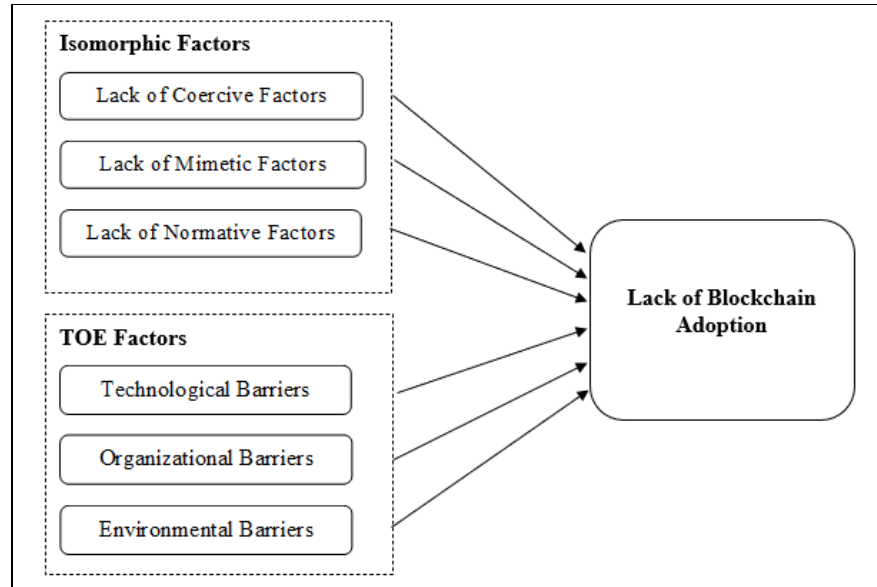
Figure 1: Theoretical